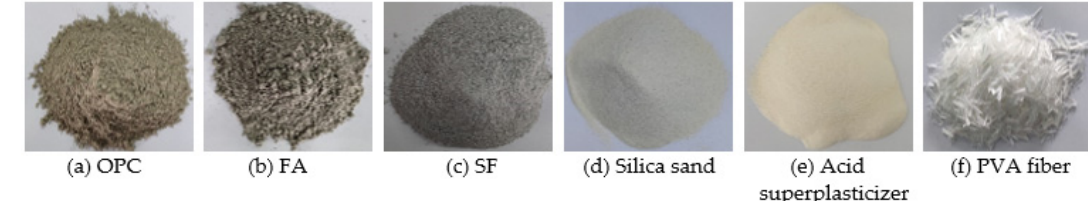
Figure 1. Experimental materials.